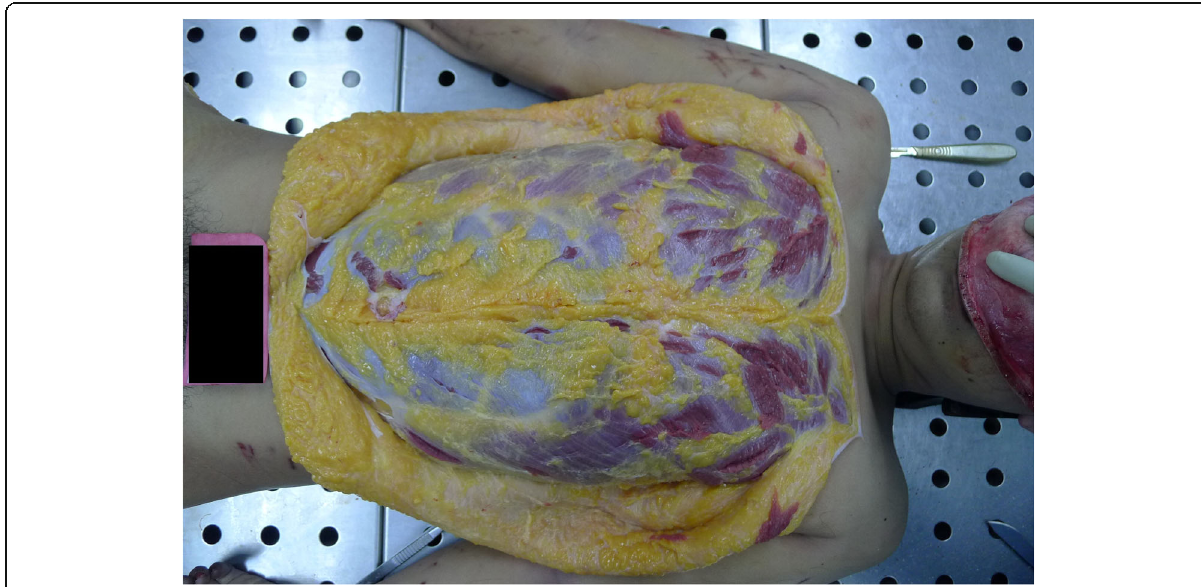
Fig. 9 There were no subcutaneous injuries of visceral organs. None of the external wounds were fatal in